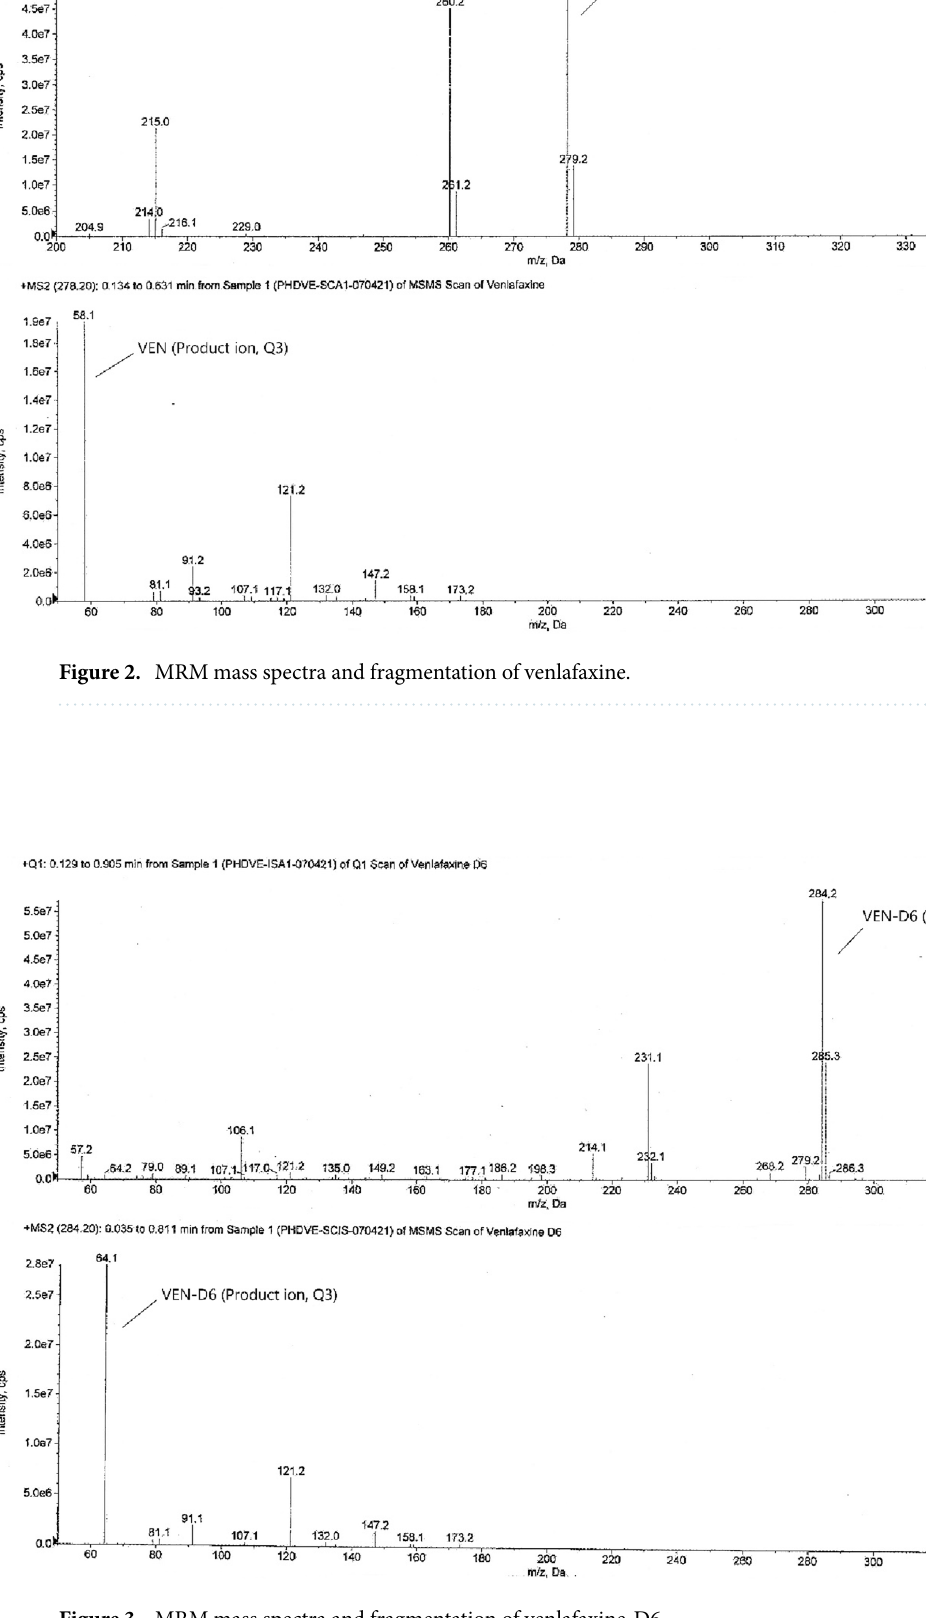
Figure 3. MRM mass spectra and fragmentation of